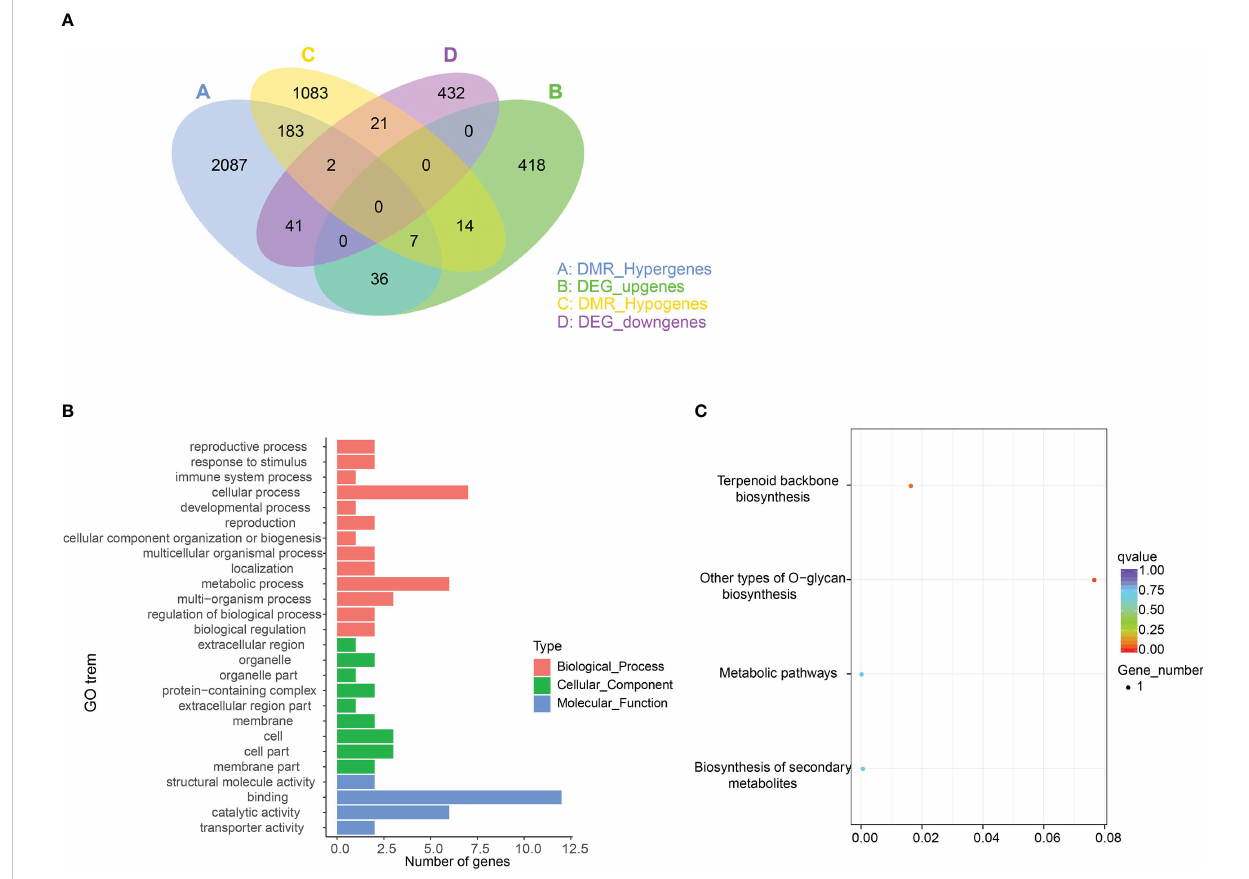
FIGURE 10 Combined analysis of DMR-related genes and DEGs. (A) Venn diagram of DMR-related genes and DEGs. (B) GO enrichment of 121 overlap genes. (C) KEGG enrichment of 121 overlapping